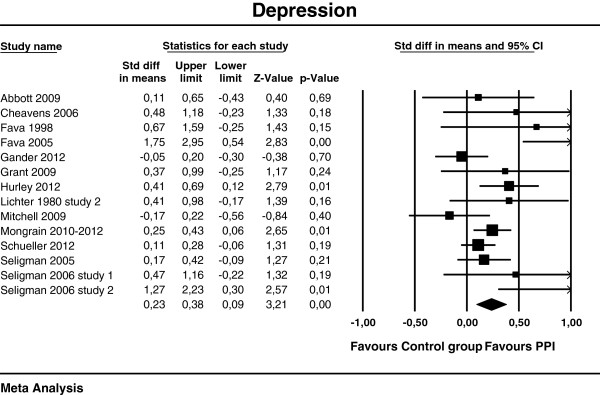
Post-test effects of positive psychology interventions on depressive symptoms. The square boxes show effect size and sample size (the larger the box, the larger the sample size) in each study, and the line the 95% confidence interval. The diamond reflects the pooled effect size and the width of the 95% confidence interval.